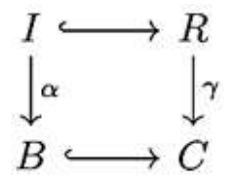
Diagram 6: B is sps-pure sub-module in C .